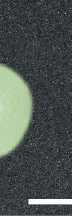
Figure 1. The egg development and hatching process of P. xylostella . Scale bar = 200 μ m. n = 33. ( A ) Stage I: Eggs were evenly white when they were just laid, and the egg chorion was full. ( B ) Stage II: Stemmata pigmentation. Pigmentation of the stemmata began with a red spot and then darkened and, finally, turned black. ( C ) Stage III: Head capsule pigmentation. The segmentation was complete at the moment. ( D ) Stage IV: The cuticular structures of the embryo have acquired their distinctive larval morphology, and the liquid in the eggs was fully absorbed.